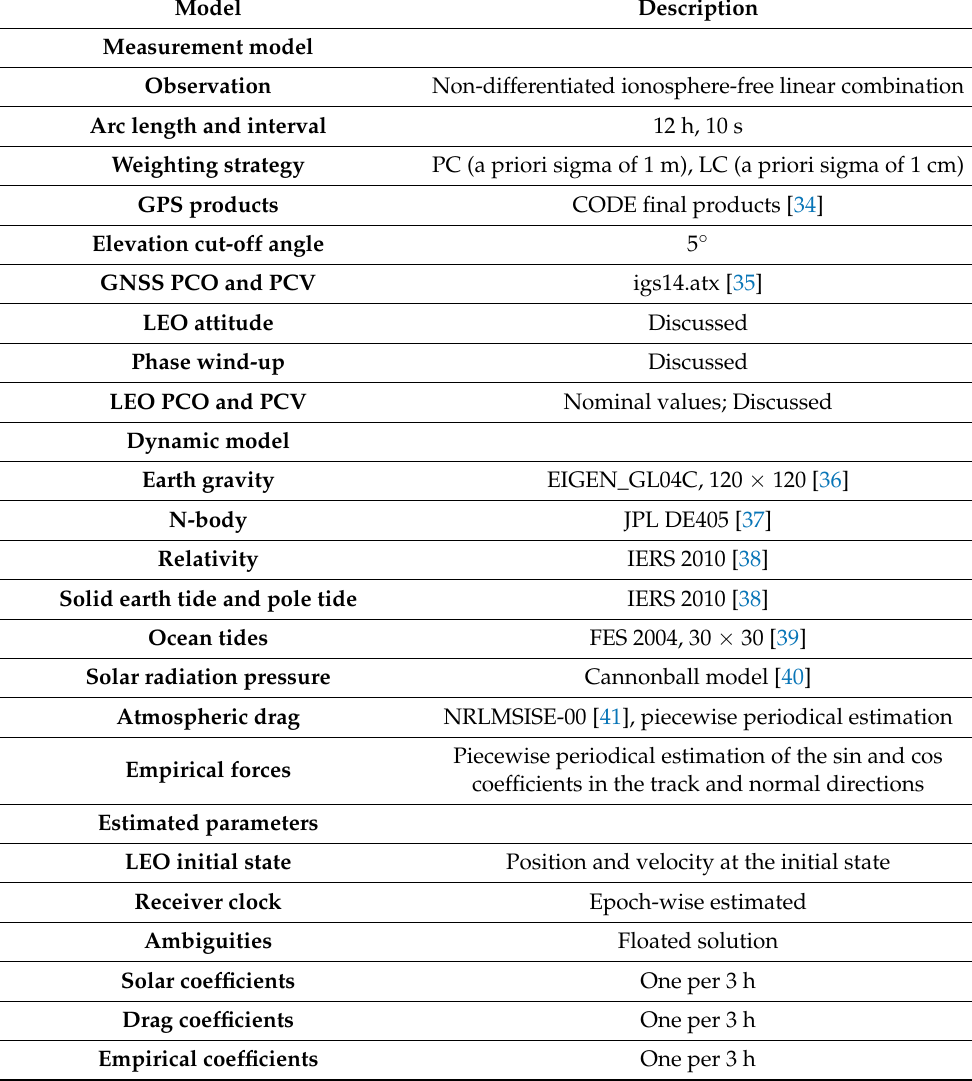
Table 1. Processing strategies for testing